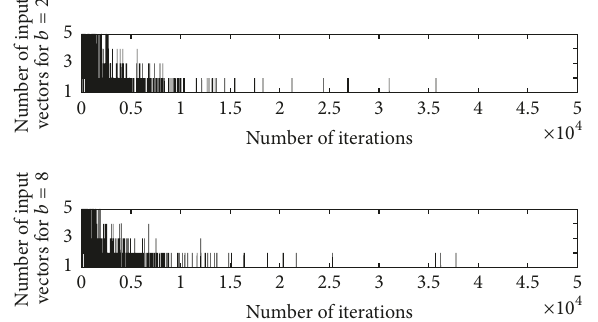
Figure14:NumbersofinputvectorsusedintheproposedFXECAP- L algorithm when 𝐿 = 5 and 𝑏 = 2 or 𝑏 = 8 .